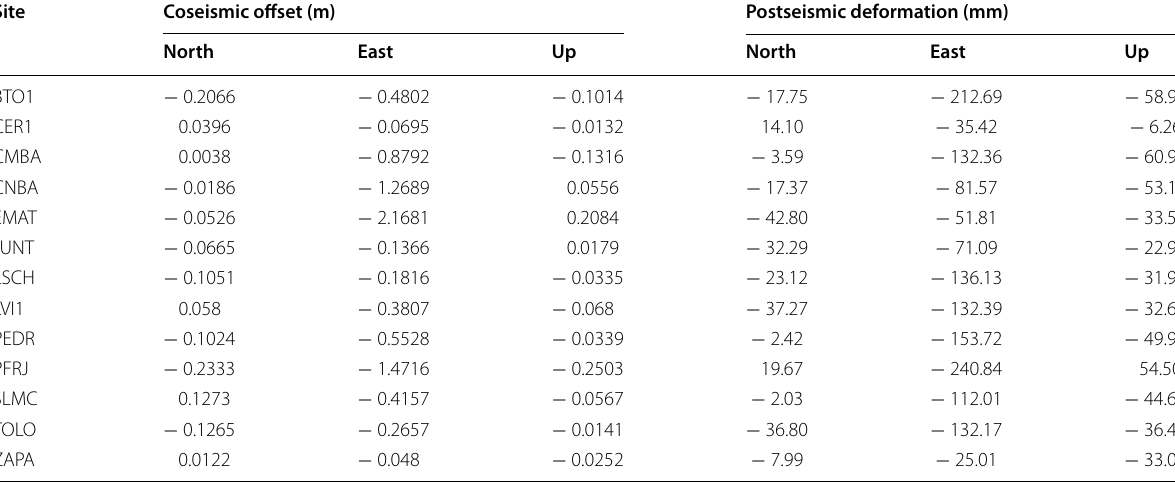
Table 1 Coseismic offsets and the accumulated deformations during 1 year after this earthquake of 13 GNSS sites Site Coseismic offset (m) Postseismic deformation (mm)